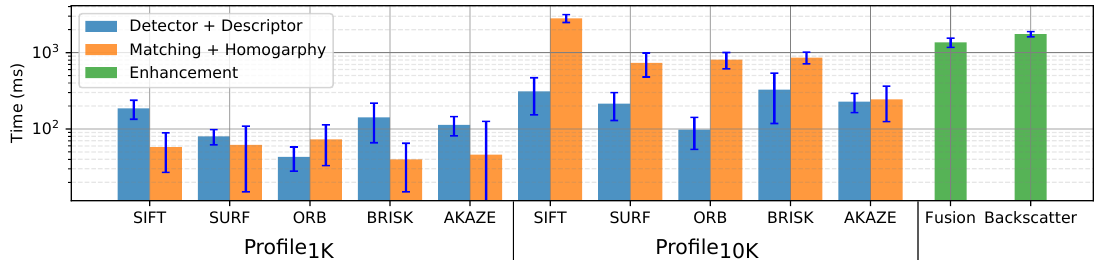
Figure 10. Processing average time per frame based on